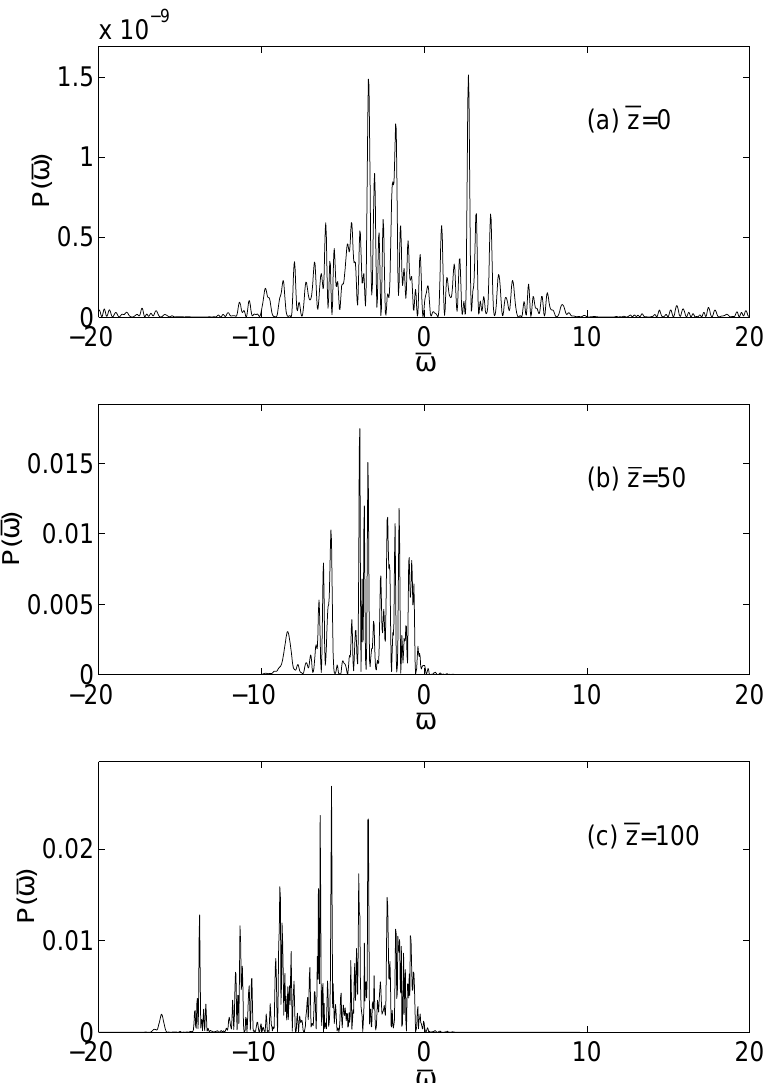
Figure 10. SASE mode operation: power spectrum of the intensity shown in Figure 9 vs. ¯ ω = ( ω − ω s ) /2 ρω s ; ( a ) ¯ z = 0; ( b ) ¯ z = 50; ( c ) ¯ z =